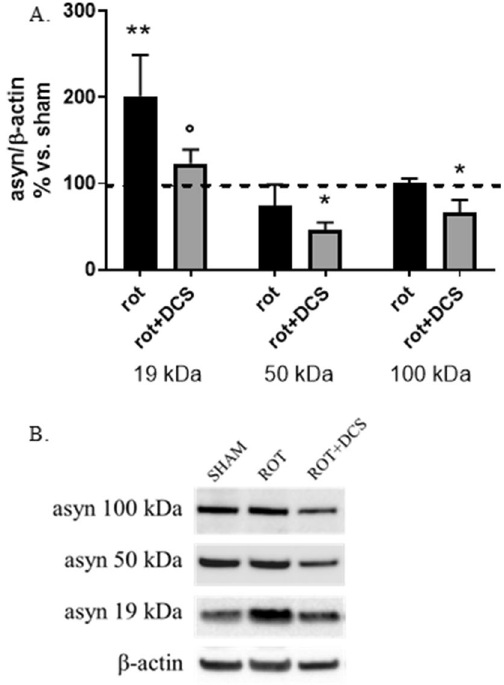
Figure 5. Effects of DCS on protein expression of monomeric (19 kDa) and oligomeric/aggregated (50 and 100 kDa) asyn forms in cells treated with rotenone (400 nM, 24 h); cells were collected 17 h after DCS (R17); the effect of rotenone alone on asyn was also shown. DCS counteracted the rotenone-induced increase of monomeric asyn and reduced oligomeric/aggregated asyn forms ( A , B ). ( B ) Representative Western blot image showing immunoreactivity for monomeric (19 kDa) and oligomeric/aggregated (50 and 100 kDa) asyn forms and β-actin, used as internal standard, in cells exposed to sham and cells treated with rotenone alone or rotenone and DCS. Full-length blot is presented in Supplementary M&M. (N = 3; **p < 0.01, *p < 0.05 vs. untreated cells, °p < 0.05 vs. rotenone-treated